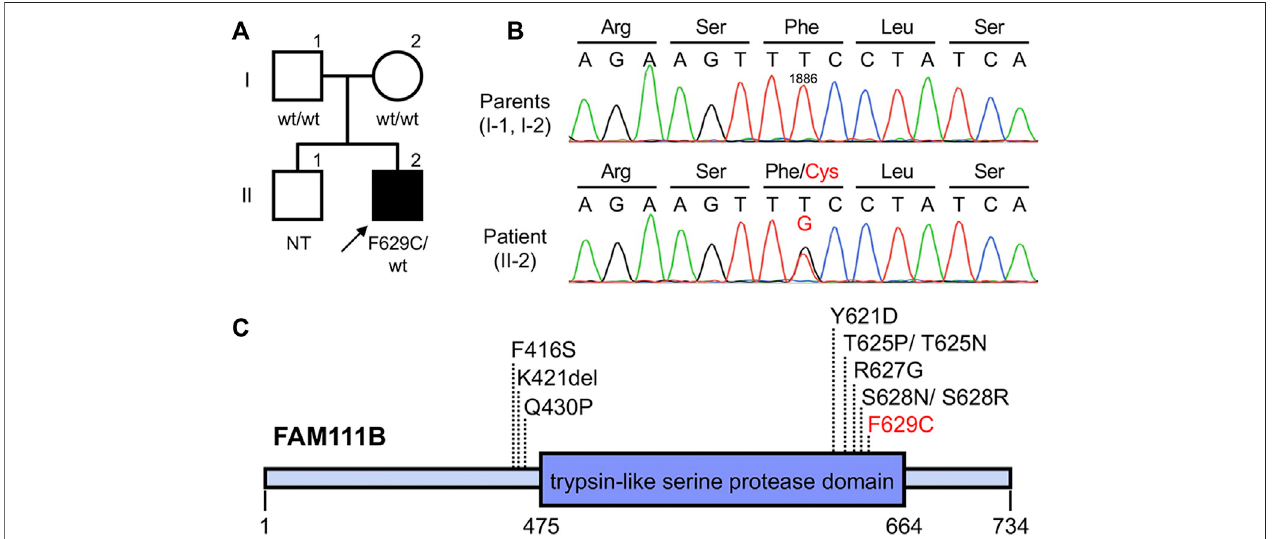
FIGURE 2 | Pedigree and genetic analysis of FAM111B (A,B) Pedigree of this case (A) . The patient was heterozygous for (C) 1886T > G (p(Phe629Cys)) in FAM111B, whereas hisparentsdid not harbor this mutation (B) . wt, wild-type; NT, nottested (C) Overview of POIKTMP-related mutations detected in the present case and previous cases.